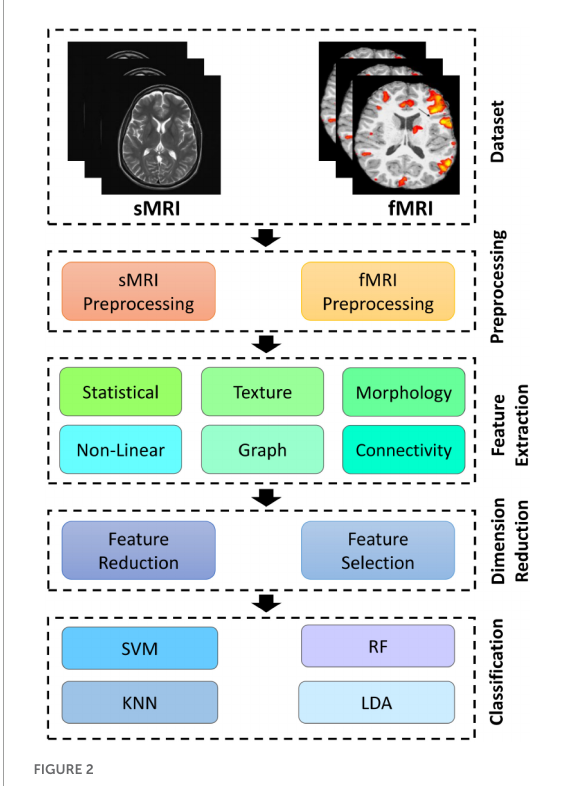
FIGURE2 Block diagram of CADS- based on ML techniques for automated ASD diagnosis.